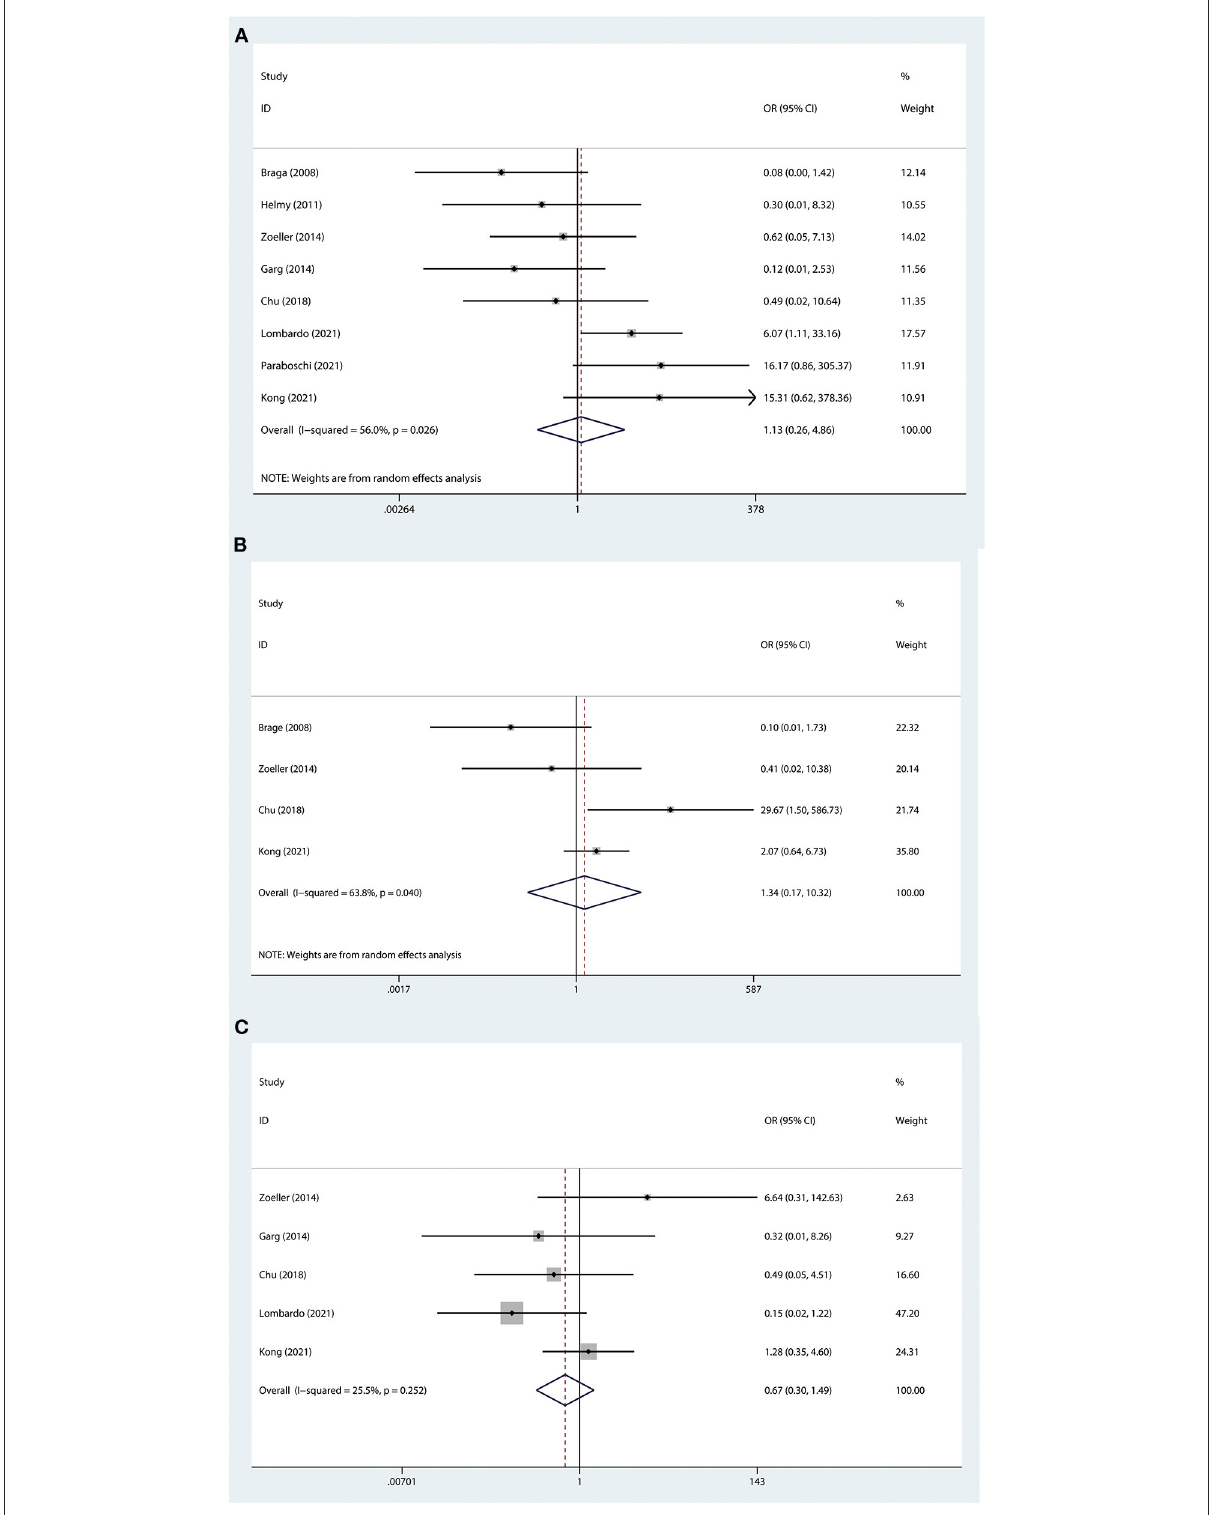
FIGURE3 Forest plot of major complication. (A) stent dislodgement. (B) stent leakage. (C) urinary tract infection. The horizontal lines represent 95% CI. The intersection of diamond and vertical line means that the difference is not statistically